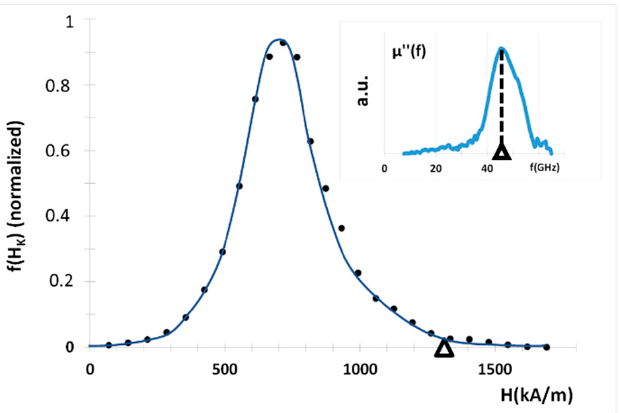
Figure 10. Anisotropy field distribution f ( HK ) of the sample BaM ‐ 0. The triangle shows the value of HK as measured by using microwave experiment (see main text). Inset: the frequency variation of the imaginary part of permeability (µ’’) shows a maximum at frequency fR = 46.6 GHz. To this value of fR corresponds the maximum value H K of the anisotropy field distribution (both are marked by a triangle), the relationship beween fR and HK being fR = γ H K .